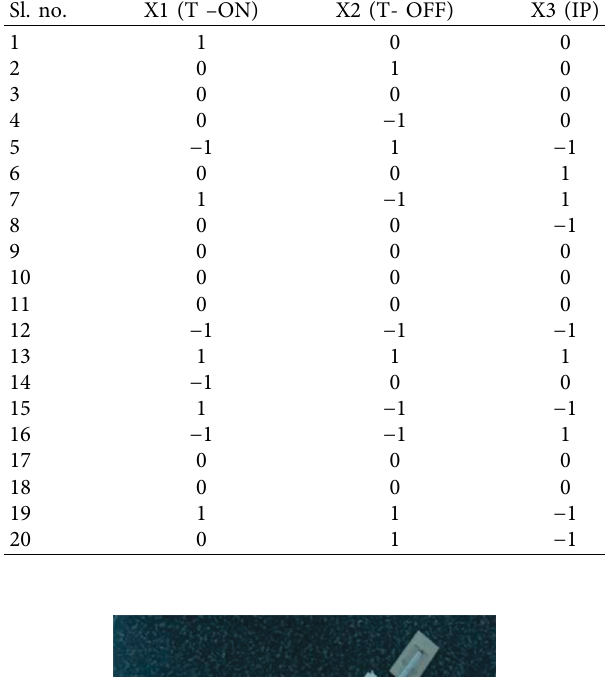
Table 4: Response surface methodology design. Sl. no.